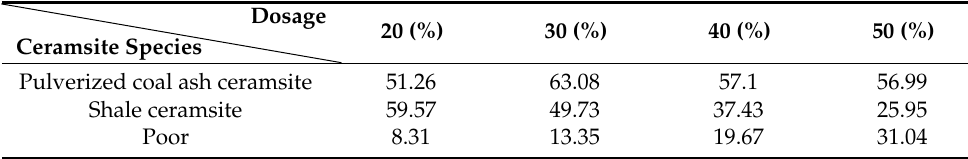
Table 5. Analysis of the 28 − day compressive strength of